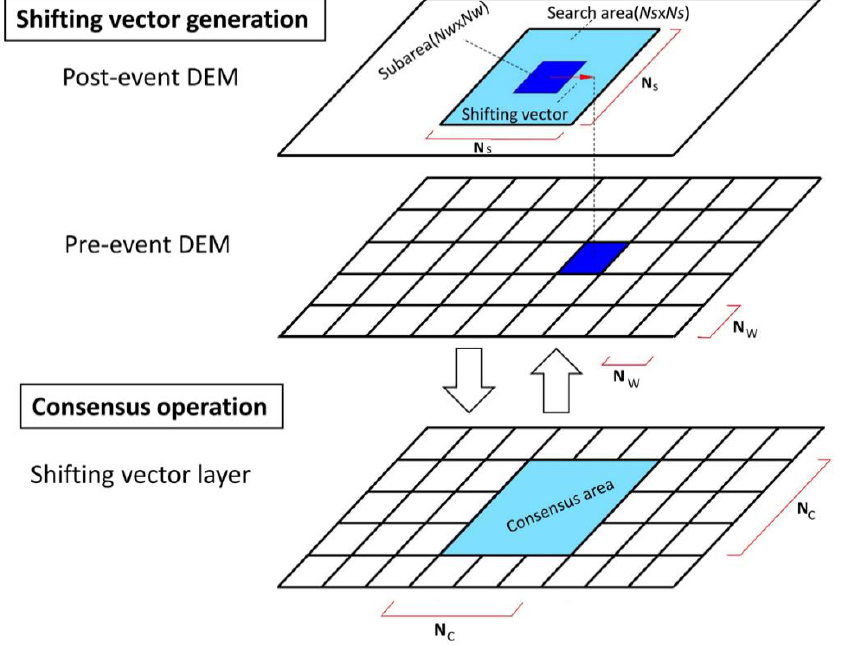
Figure 7. The schematic diagram for nonlinear mapping operations presents the segmentation of both pre – and post – event DEMs, the matching segments process, generating shifting vectors, and correcting false generated shifting vectors using the consensus operation, the figure is modified from [21].